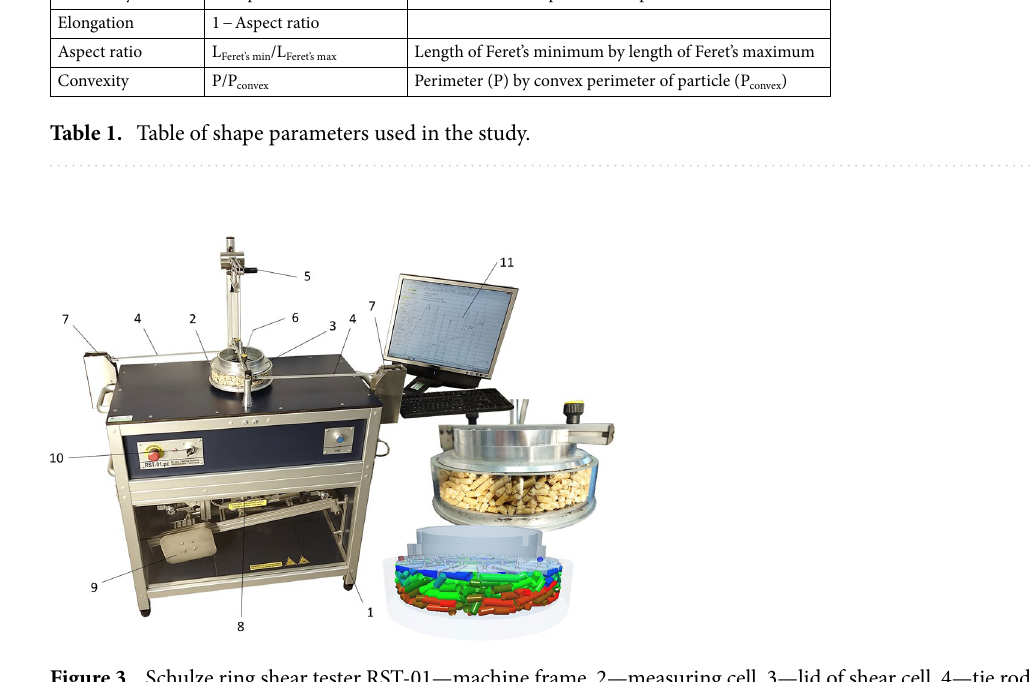
Figure 3. Schulze ring shear tester RST-01—machine frame, 2—measuring cell, 3—lid of shear cell, 4—tie rods, 5—counterweight, 6—suspension rod, 7—strain gauges, 8—lever load system, 9—moving weights, 10—main switch, 11—PC with evaluation